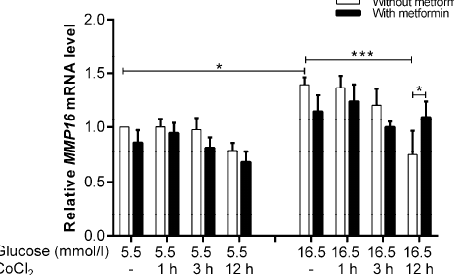
Figure 6. Effect of metformin on MMP16 mRNA expression in euglycemic and hyperglycemic conditions with CoCl 2 induction. The variation in RNA expression levels of MMP16 was assessed by qRT-PCR on three independent biological replicates. Results are presented as mean ± SEM and were analyzed using one-way ANOVA followed by LSD. * p < 0.05, *** p < 0.001 compared to the control or hyperglycemia or pairwise, i.e., metformin-treated condition versus untreated condition. Table 1. The top differentially expressed genes in HUVEC treated with metformin and exposed to hyperglyemia-CoCl 2 .